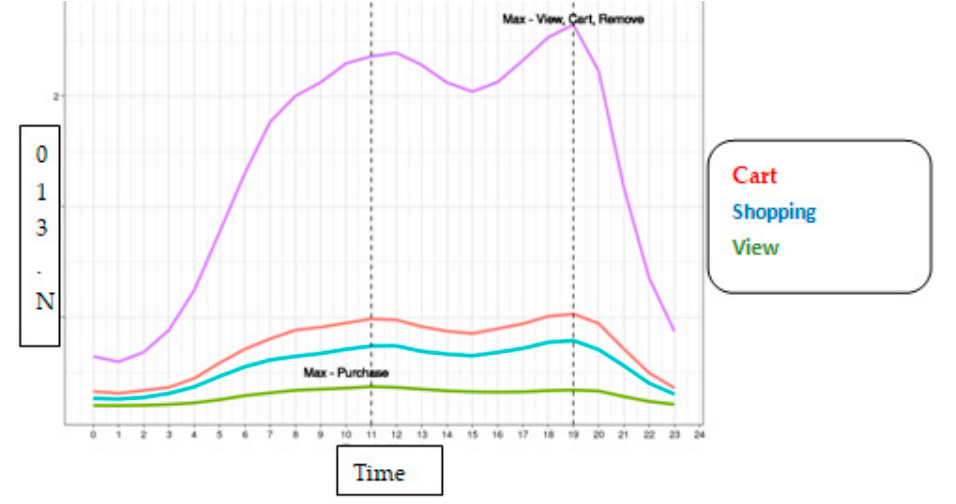
Figure 10. Evenet based prediction.